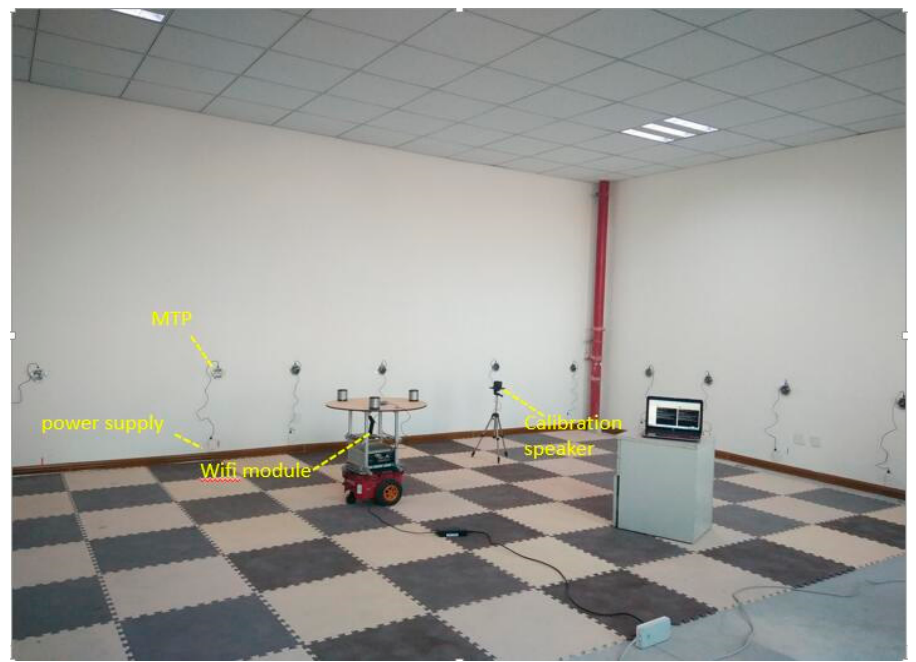
Figure 17. Positional relationship of the sound source array, robot, and landmarks for the experiment.